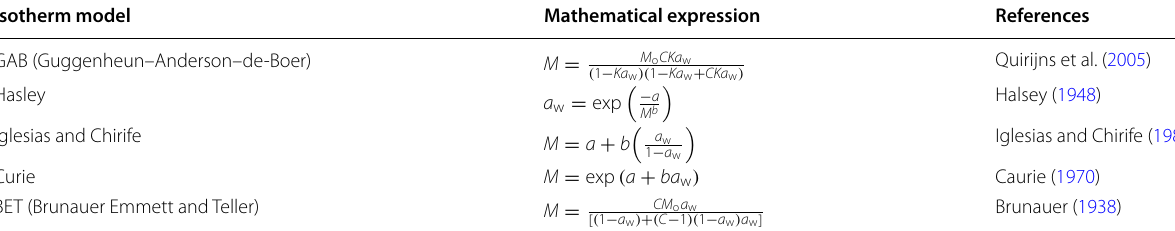
M , EMC, % db; a w , water activity; a and b , constants; M o , monolayer moisture content, % db; C Guggenheim constant; and K , factor correcting for properties of multilayer molecule with respect to the bulk liquid